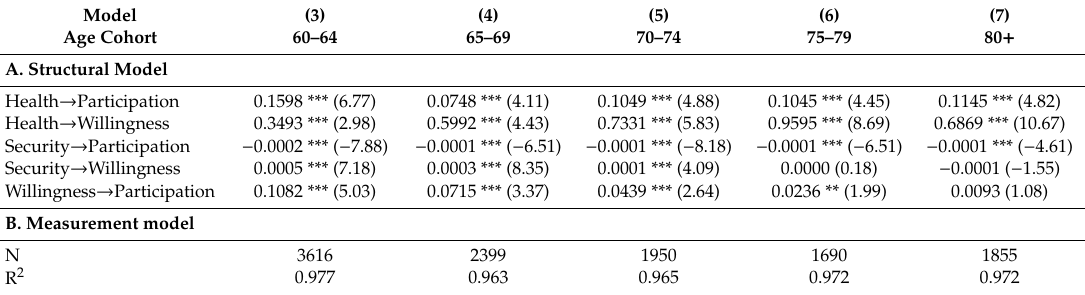
Table 5. Multi-group comparison by age cohort (N =